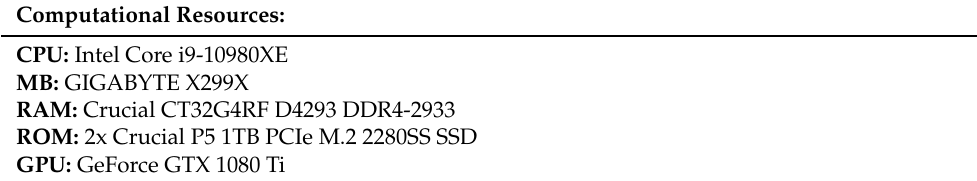
Table A1. Computational